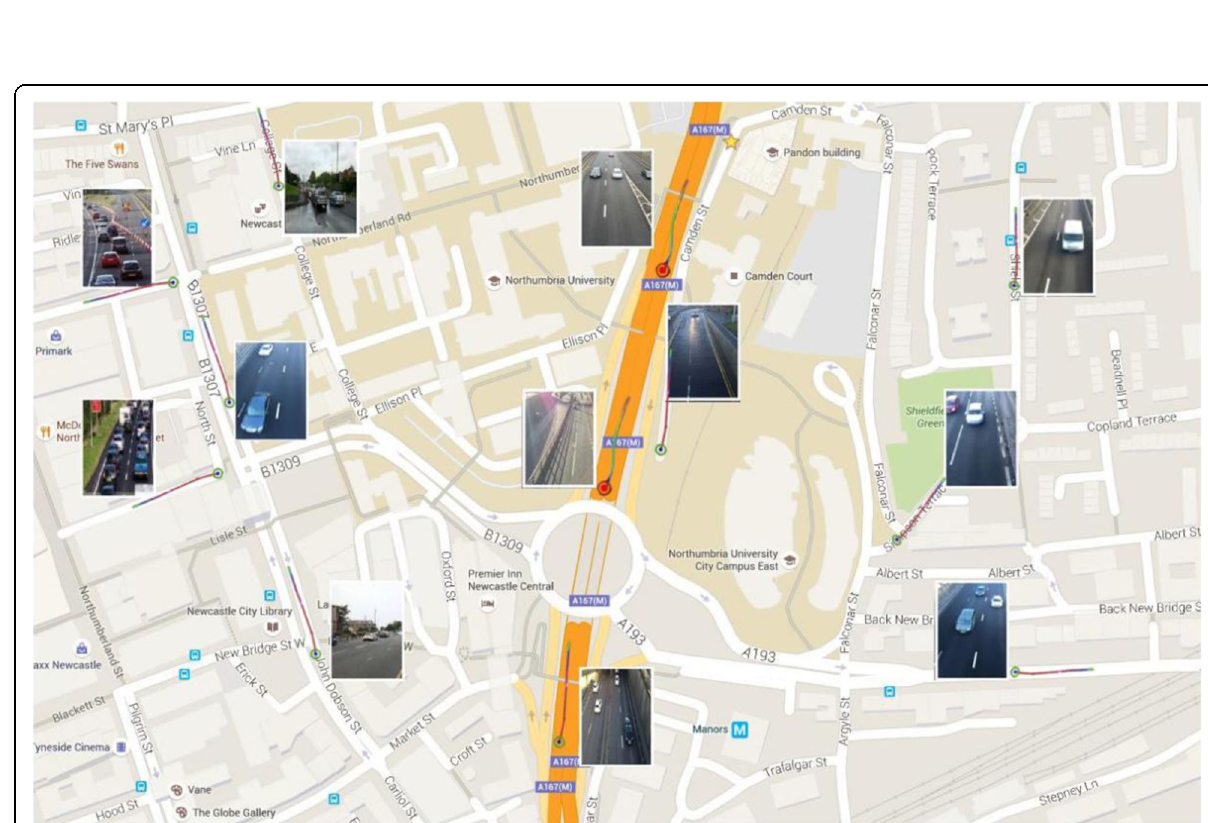
Fig. 24 Time-stamped semantic glyph on Google